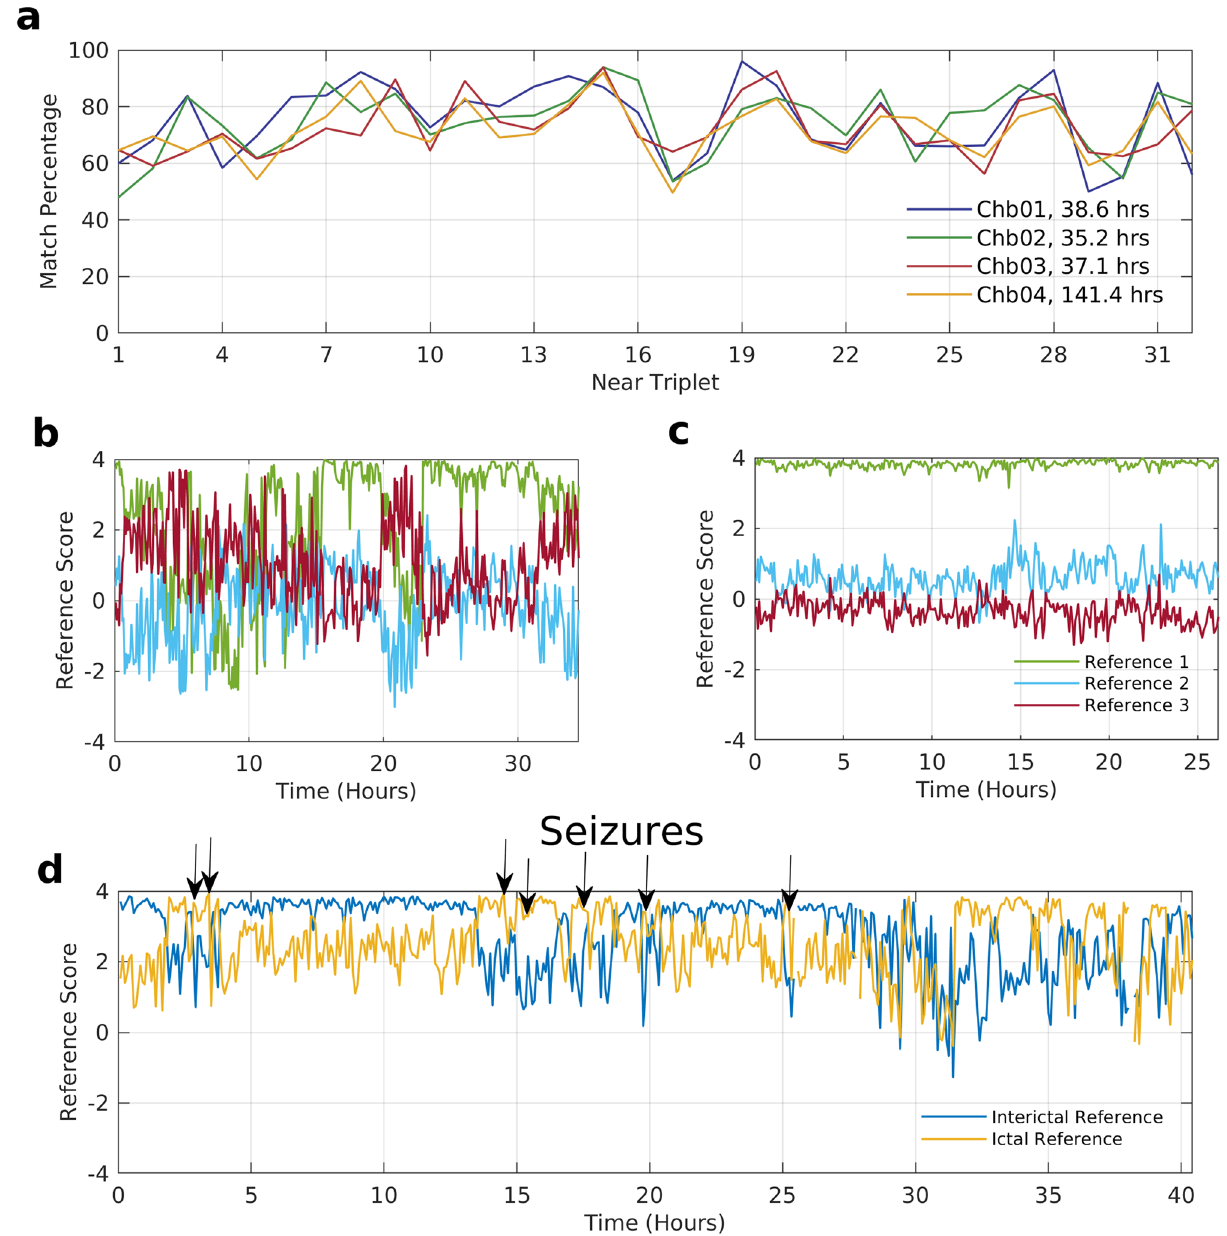
Figure 6. Temporal prevalence and evolution of rdFC patterns in data set 5. ( a ) Match percentage of first four subjects in data set 5 across all six permutations of each triplet. The patterns for each subject are obtained from each successive 5-min epoch of the entire EEG record of the respective patient. All the four EEG recordings are more than 24 h in duration, with record Chb04 spanning several days. Match scores for a specific permutation chosen for each triplet location with respect to all the three reference patterns when ( b ) there are regular fluctuations in the scores and ( c ) when the scores remain steady throughout the period of the recording. ( d ) Match scores of a specific permutation for a triplet location where seizure linked transitions in the rdFC patterns occur. The scores are with respect to two references that were obtained from an EEG epoch just before the third seizure (ictal reference) and an EEG epoch four hours prior to the third seizure (interictal discovered that the probability of a particular pattern matching with one of three reference patterns was strongly determined by which coordinate was carrying the lowest correlation coefficient value at the first order of con- nectivity, i.e., the first point of the 5-point pattern. Based on our choice of coordinate assignment, we observed that when the lowest correlation coefficient of the first point of the 5-point connectivity pattern was at x coordinate the pattern matched with reference 3, when at y coordinate it matched with reference 2, and with reference 1 when at z coordinate. To test this hypothesis, we took all the patterns that matched the references from all the data and triplet sets and selected the ones that